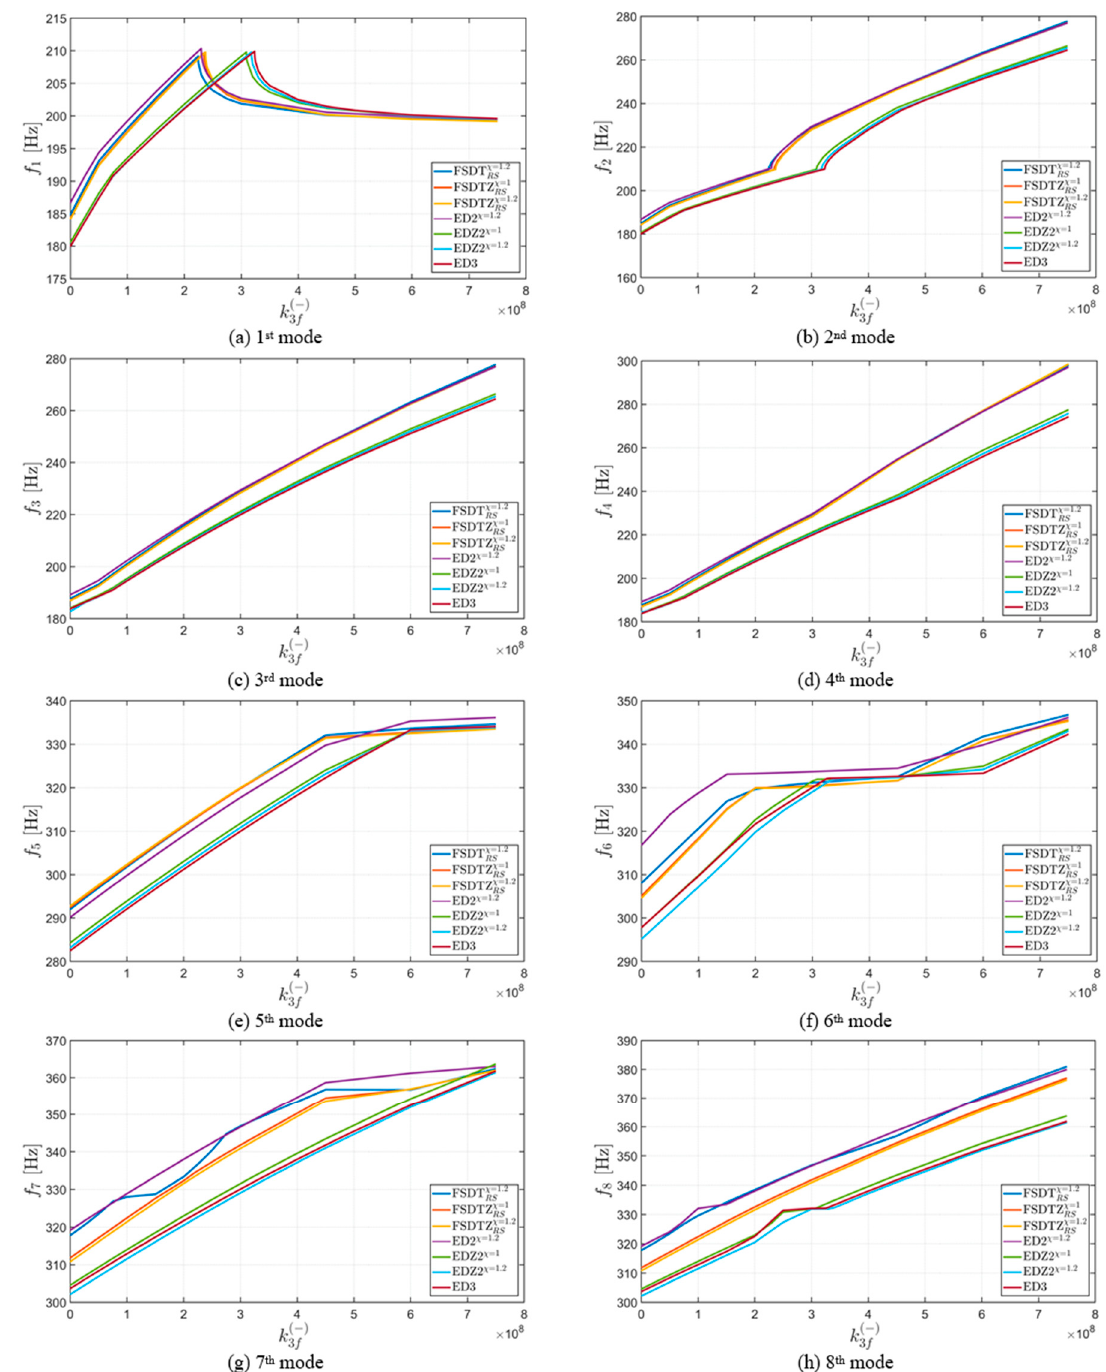
Figure 8. Frequency variations of a CFCF cylindrical surface (Figure 4b) reinforced by CNTs distributed as in Figure 5b. The mass fraction is w r = 0.25, and the agglomeration parameters µ 1 = 0.5 and µ 2 = 0.75. The Chebyshev-Gauss-Lobatto grid distribution was employed, with I N = I M = 25. The following mode shapes are considered: ( a ) 1st mode; ( b ) 2nd mode; ( c ) 3rd mode; ( d ) 4th mode; ( e ) 5th mode; ( f ) 6th mode; ( g ) 7th mode; ( h ) 8th